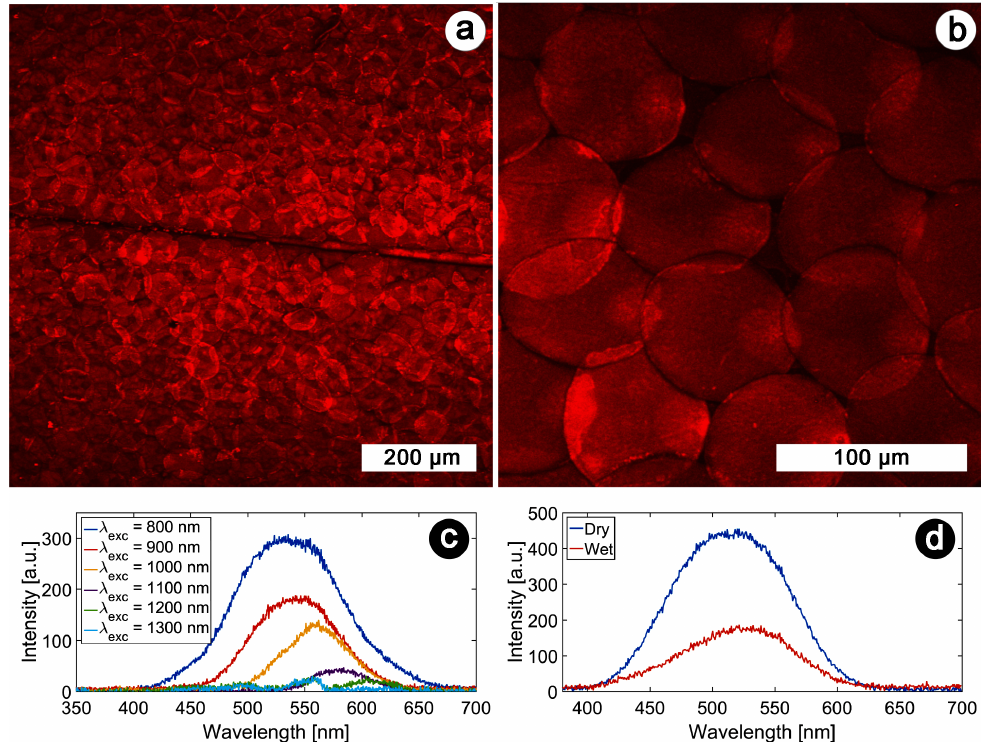
Figure 6. TPEF microscopy and spectroscopy of the scales covering H. coerulea ’s elytra. An intense TPEF response was detected from the elytra of the male beetle H. coerulea with an excitation wave- length equal to 900 nm ( a ) and 800 nm ( b ). TPEF excitation spectra were measured with various excitation wavelengths ( c ). Upon contact with water ( d ), the emitted intensity decreases and the peak wavelength red-shifts slightly (the excitation wavelength equals 800 nm). Scale bars: ( a ) 200 µm and ( b ) 100 µm. Reproduced from Mouchet, S. R., Verstraete, C., Mara, D., Van Cleuvenbergen, S., Finlayson, E. D., Van Deun, R., Deparis, O., Verbiest, T., Maes, B., Vukusic, P., and Kolaric, B., 2019 Nonlinear optical spectroscopy and two-photon excited fluorescence spectroscopy reveal the excited states of fluorophores embedded in a beetle’s elytra, Interface Focus 9(1), 20180052, with permission from The Royal